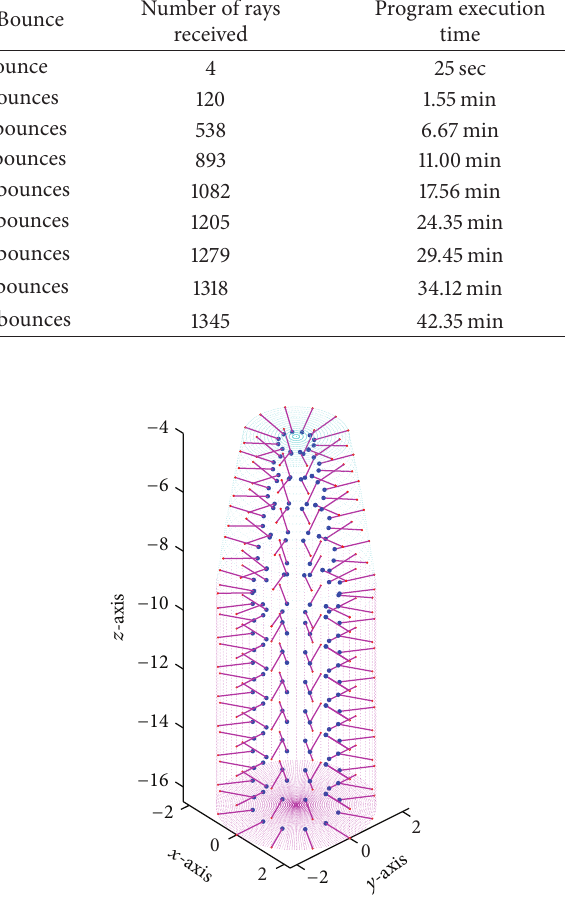
Figure 4: The unit surface normal vector representation of GPOR frustum and right circular cylinder.